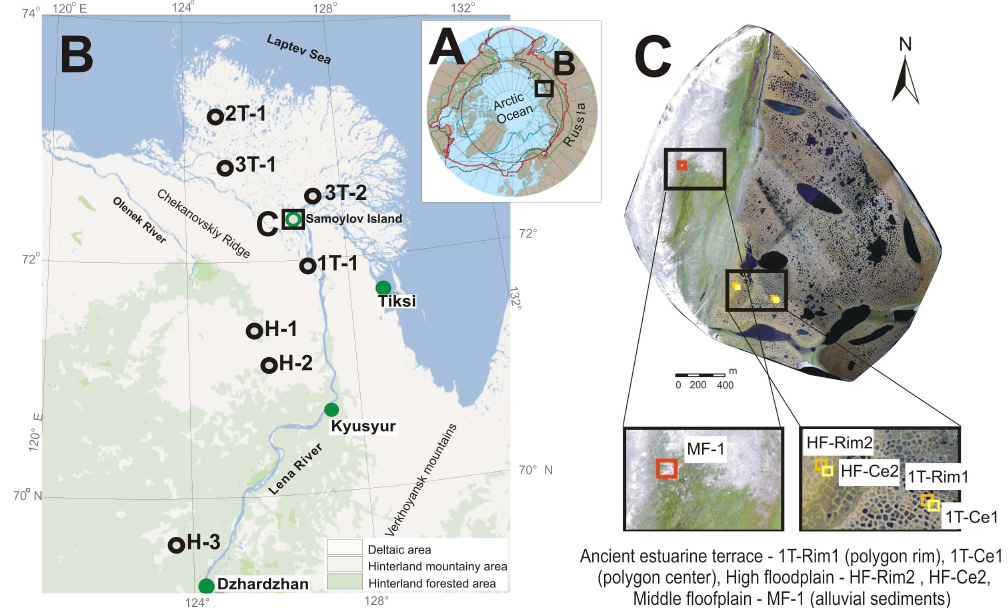
Fig. 1. (A) The position of the study area in the circum-Arctic, (B) an overview of the area in northern Siberia with location of study sites investigated in 2009, and (C) an overview of Samoylov Island with study site positions investigated in 2010. The maps are based on Google and Geocentre Consulting, AMAP and an orthorectified aerial picture of Samoylov, 2007 (SPARC-group, Alfred Wegener Institute,